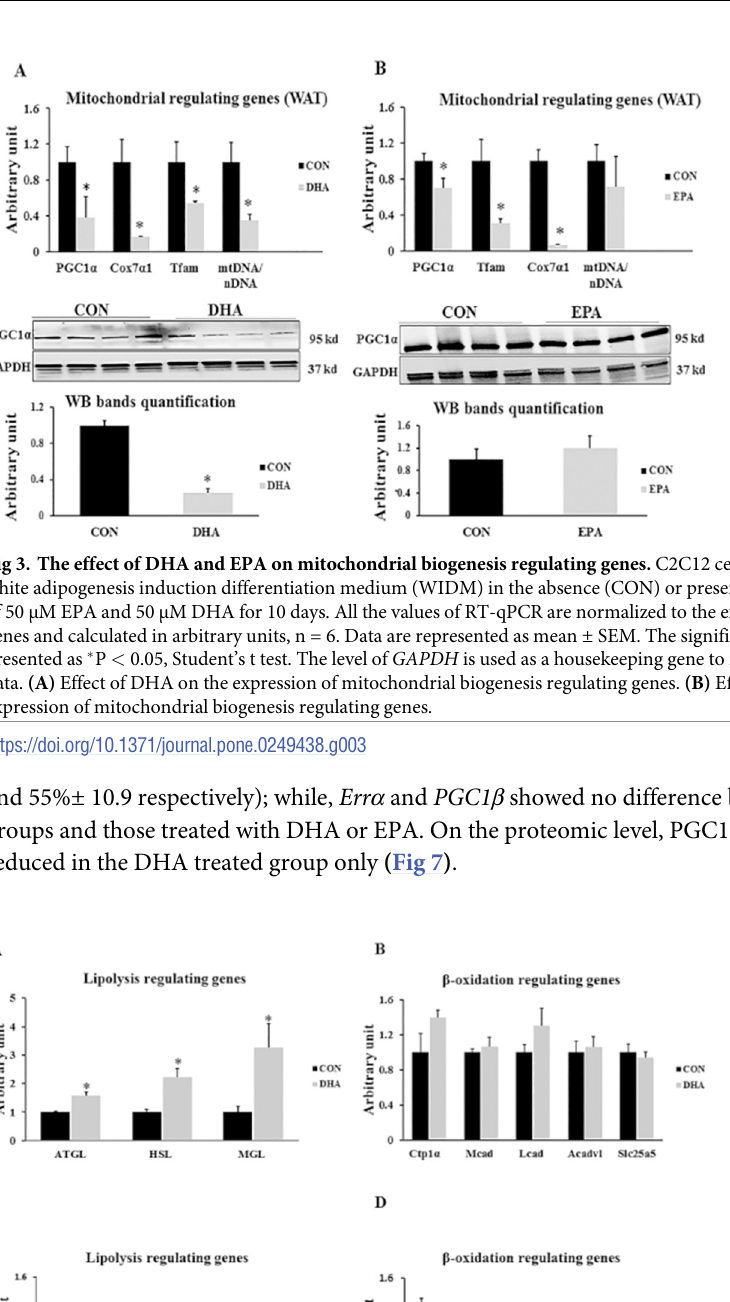
Fig 4. The effect of DHA and EPA on genes regulating basal lipolytic and β -oxidation. C2C12 cells were treated with white adipogenesis induction differentiation medium (WIDM) in the absence (CON) or presence of individual doses of 50 μ M EPA and 50 μ M DHA for 10 days. The values are normalized to the expression levels of 18s genes and calculated in arbitrary units, n = 6 (A) Effect of DHA on the expression of genes regulating basal lipolysis. (B) Effect of DHA on the expression of genes regulating lipid uptake and β -oxidation (C) Effect of EPA on the expression of genes regulating basal lipolysis. (D) Effect of EPA on the expression of genes regulating lipid uptake and β -oxidation. Data are represented as mean ± SEM. The significant difference is presented as � P < 0.05, Student’s t test.